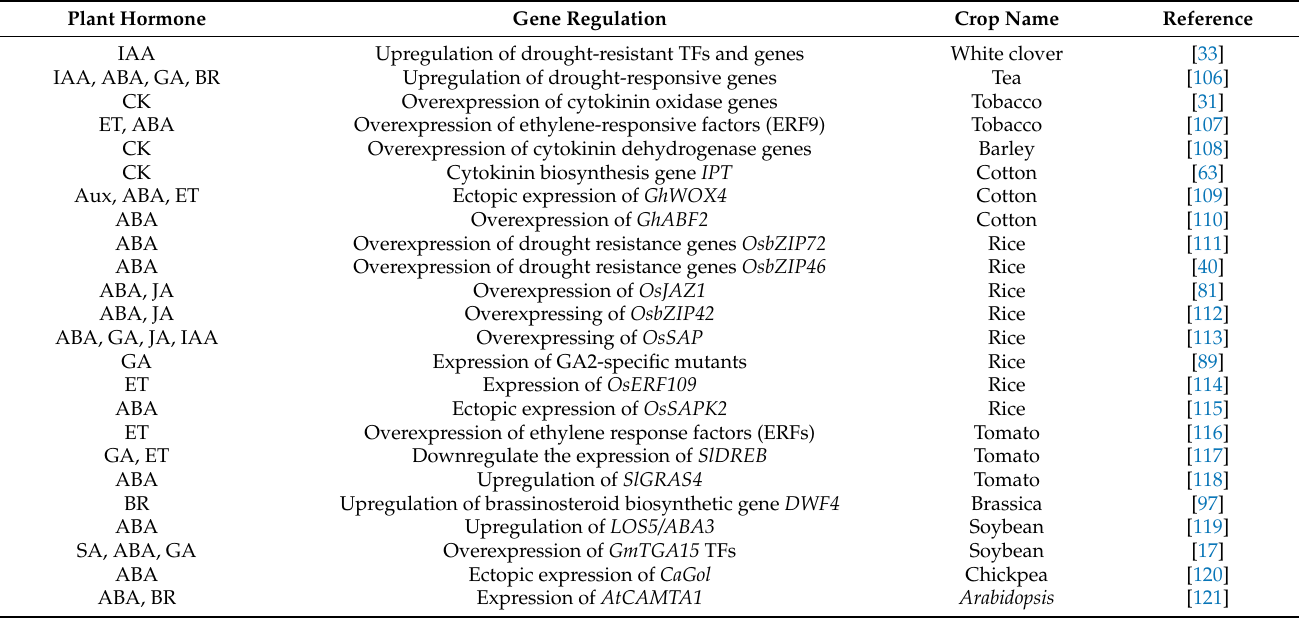
Table 1. Phytohormones regulate the drought-responsive genes in various plant species. Plant Hormone Gene